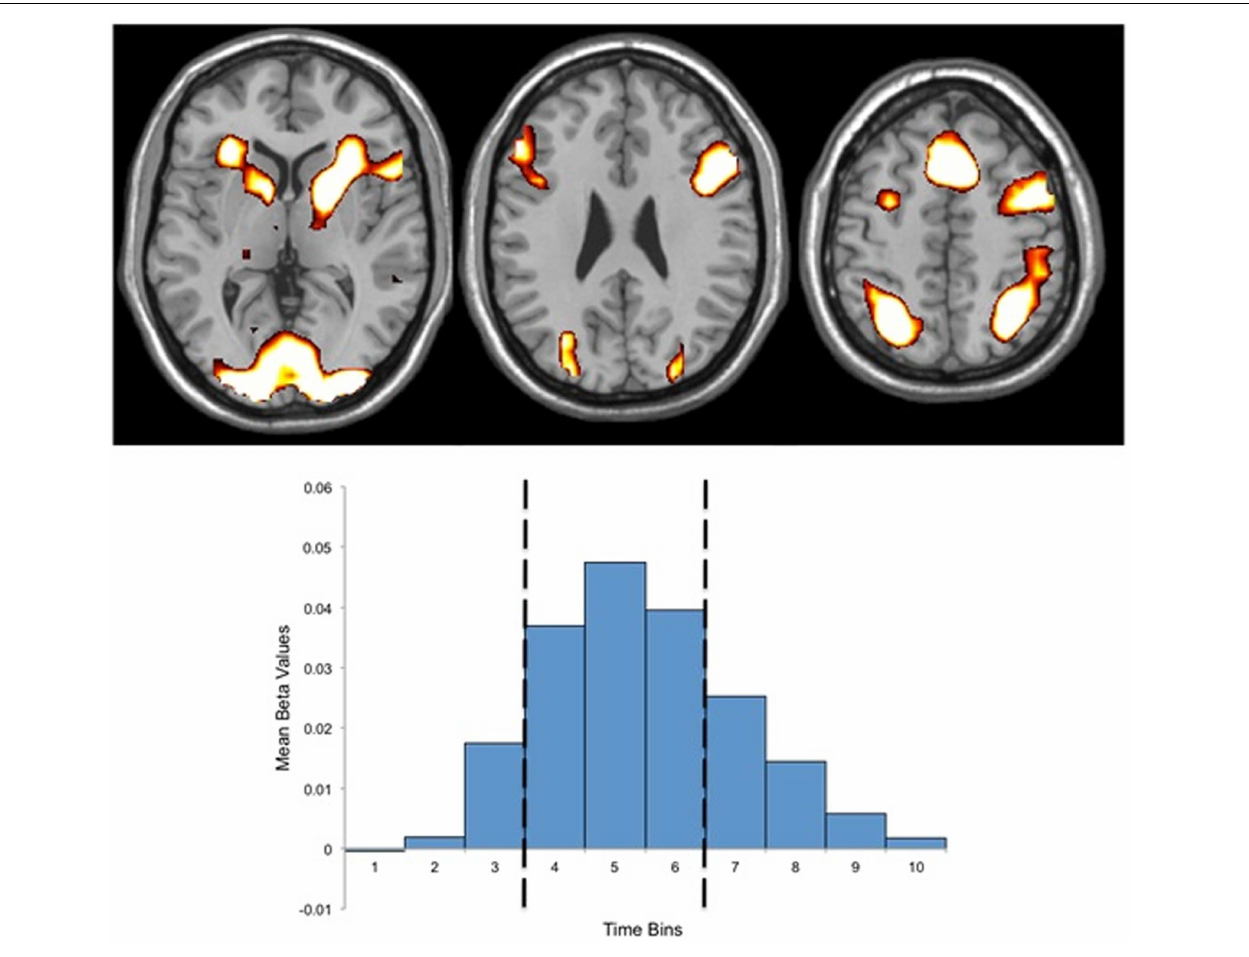
occurring during time bin five, and the three time bins used for beta estimate extraction (bins four through six). Both activations and the FIR basis set present data for both